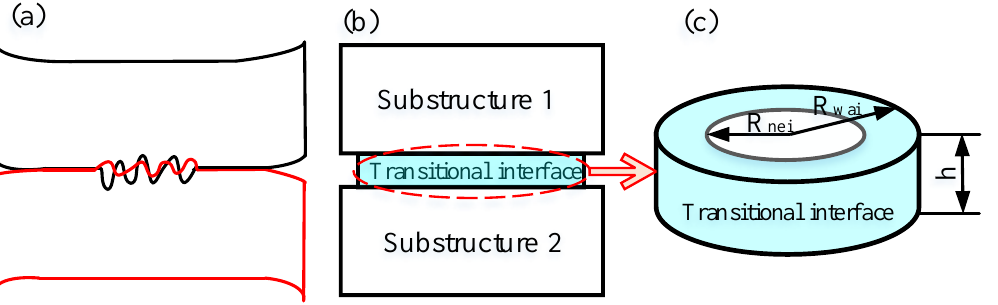
Figure 3. Bolt joint modeling: ( a ) contact station, ( b ) transitional interface model, and ( c ) geometric parameters.